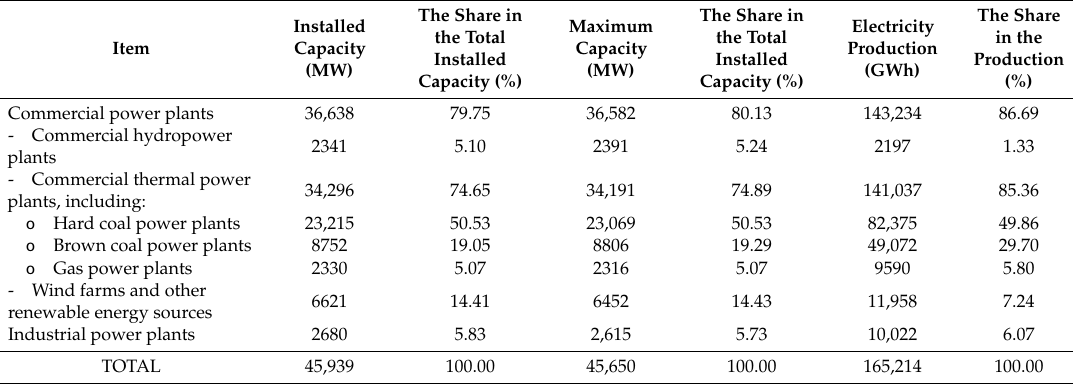
Table 2. The national power system in 2018 1